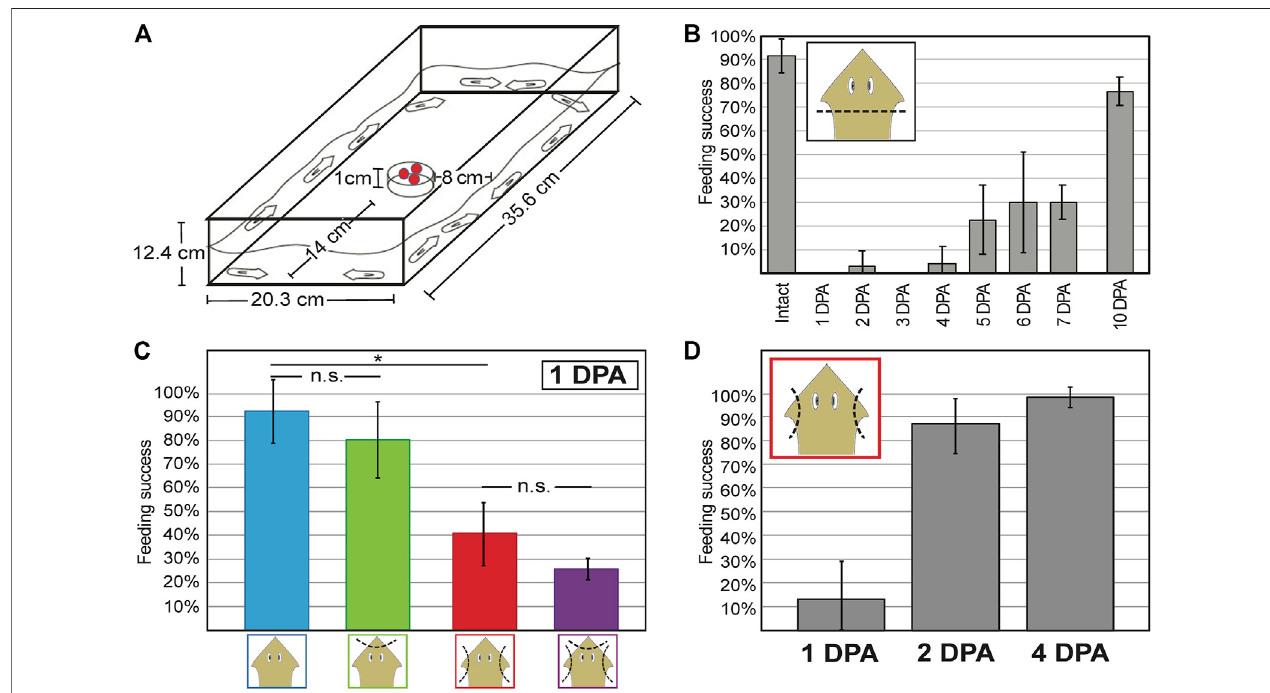
FIGURE3| Decreasedchemotacticresponseisobservedafter auricle amputation andrestored 2 days post-amputation. (A) Dimensions offeedingarena usedto measure chemotactic response. Pellets of liver mixed with agarose and food dye sit as chemoattractant on a petri dish in the center of the fi eld. (B) Bar graph illustrating the average percent of intact and regenerating planarians on different days post-amputation (DPA) of the head ( x- axis) that performed successfully in independent chemotaxis response assay trials (n ≥ 3 biological replicates) by the end of 30 min sessions. (C) Average percent feeding success of intact planarians (blue) and planarians subjected to either head tip (green) or auricle (red) amputation, or both (purple), at the end of 30-min chemotactic response assays performed 1-DPA. (D) Average percent feeding success of planarians 1, 2, and 4 days following auricle amputation (DPA) reveal recovery of chemotactic response within 48 h. Error bars illustrate standard deviation from the mean. Asterisks (*) represent Student ’ s t-test p -value ≤ 0.05. No statistical signi fi cance (n.s.) is indicated.